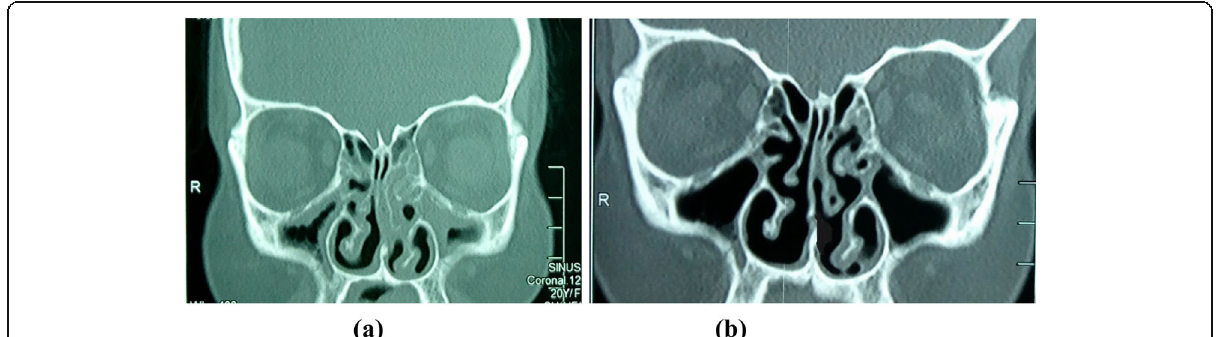
Fig. 1 CT of group A. a Pre-operative CT showing maxillary and ethmoid sinusitis. b Post-operative CT showing aireated maxillary sinus with very mild ethmoid sinusitis